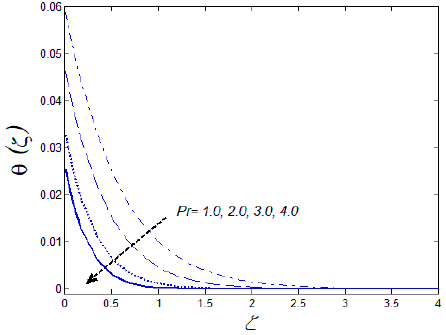
Figure 11. Upshot of Pr on temperature field θ ( ζ ) .